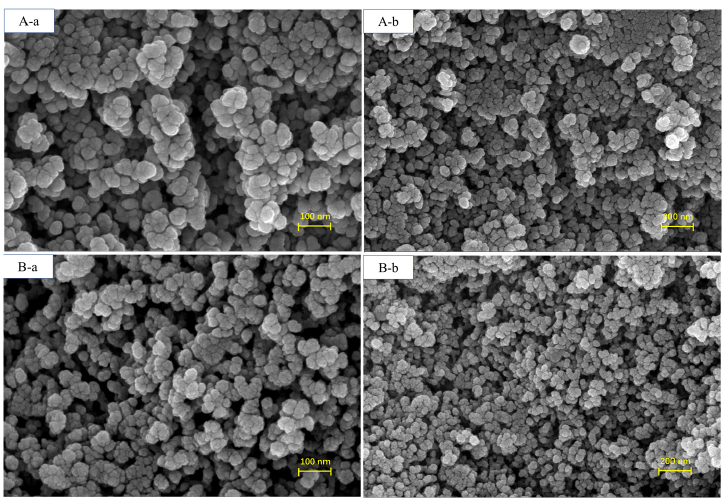
Figure 2. SEM images of ( A - a , A - b ) BMMs and ( B - a , B - b ) Pro@BMMs-SS-Py/ β -CD nanoparticles.